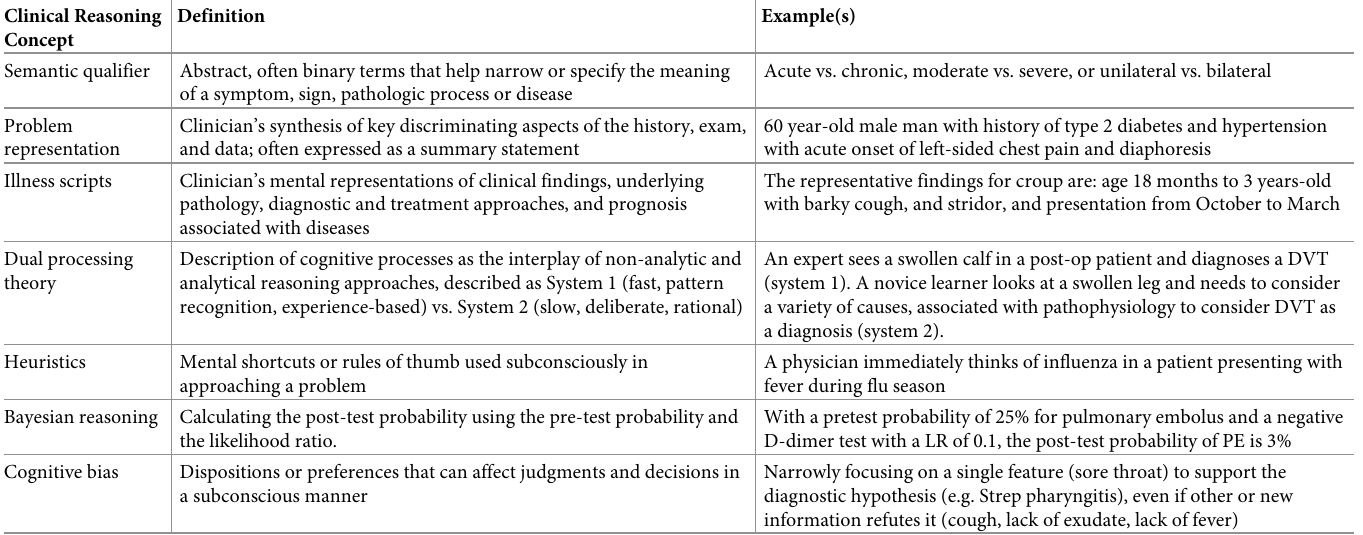
Table 1. Clinical reasoning concepts included in the